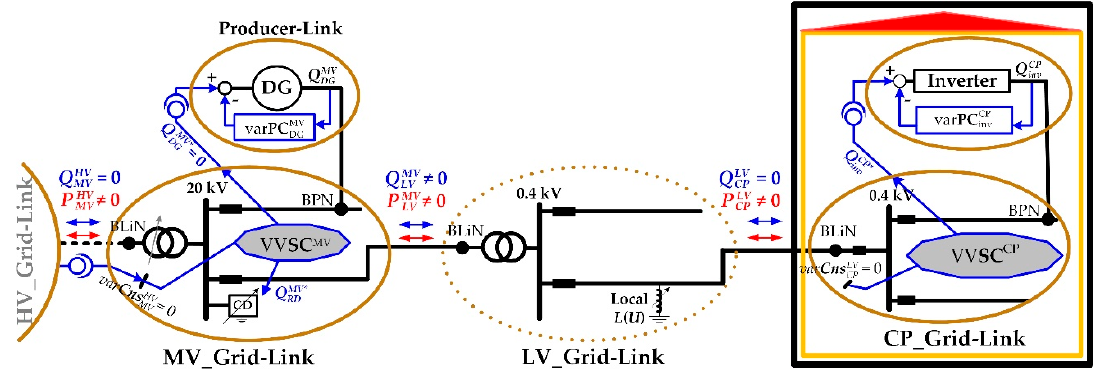
Figure 7. Simplified form of the VVC chain strategy representing the setup with L ( U )-control, CP_ Q -autarky and a CD at the STR MV-busbar.